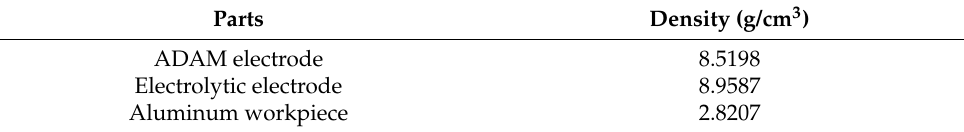
Table 6. Results of density